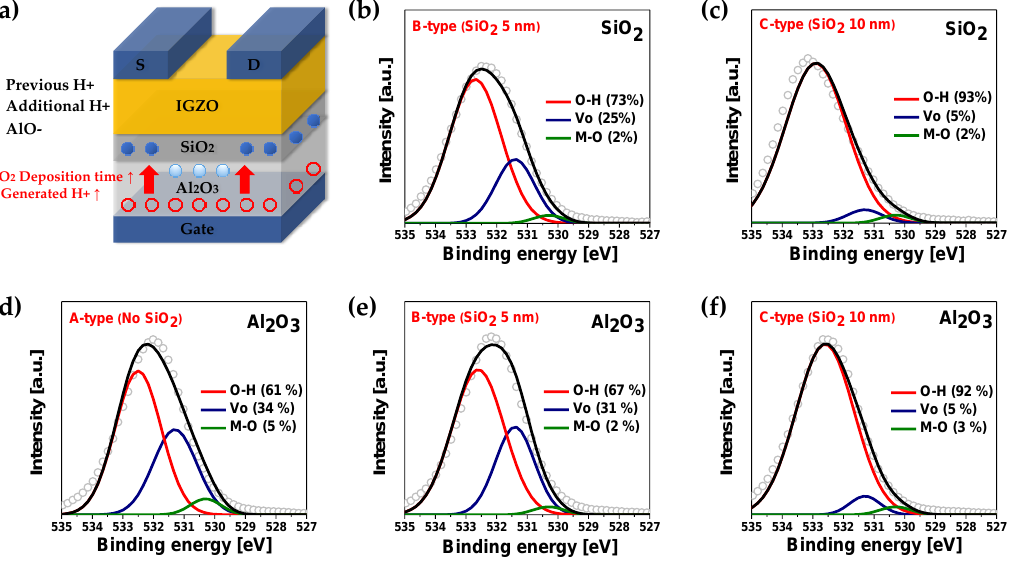
Figure 5a,b. The C-type device is considered as potential candidate for synaptic device thanks to high hydrogen content and the A-type device is verified as reference device. The A-type IGZO TFT shows 3.6 V negative V T shift under PBS and 2 V positive V T shift under NBS, which means that hydrogen ions inside the Al 2 O 3 and SiO 2 layer move toward the IGZO channel during PBS but move away from the IGZO channel again during NBS due to negative V GS . Since the C-type IGZO TFT has more hydrogen content than the A-type device due to the additional SiO 2 layer, it shows a larger V T shift under the same stress conditions ( ∆ V T = − 7.9 V/6 V under PBS/NBS). The V T is recovered through NBS in both devices. However, as the depth increases, there is no significant difference in the hydrogen the A- and C-type devices, but not fully as the initial values since some of hydrogen moving content depending on the device type. This is because additionally generated hydrogen toward the IGZO layer can form a bond with oxygen at the IGZO layer interface [40], and during the SiO 2 deposition step moved into the SiO 2 rather than the Al 2 O 3 layer due to the some hydrogen can act as a shallow donor [46]. Therefore, strong NBS condition with difference in bond dissociation energy between Si-H and Al-H. larger amplitude than PBS condition is required for sufficient V T recovery.